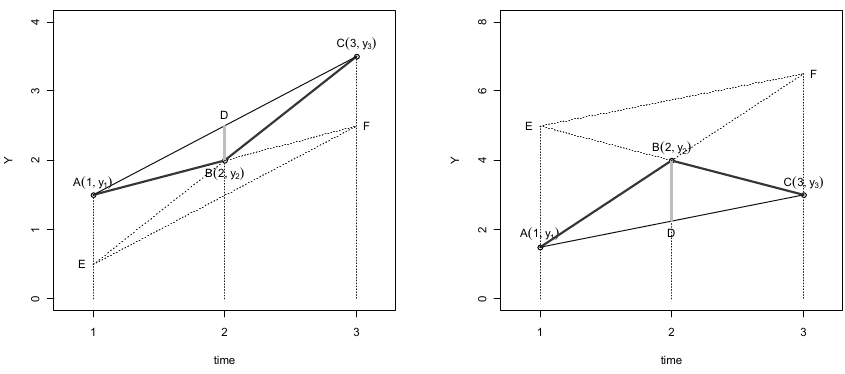
Figure 5 – Negative value of index AV it . Figure 6 – Positive value of index AV it